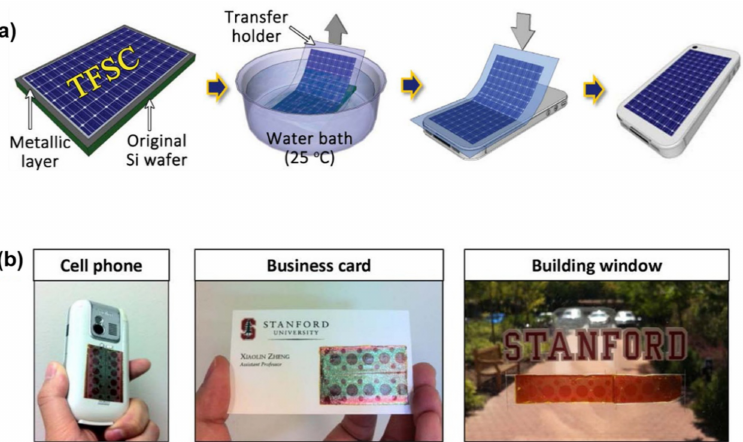
Figure 12. ( a ) Procedures of the peel-and-stick process. ( b ) Solar cells on cell phone (left), business card (middle), and building window (right). Adapted from